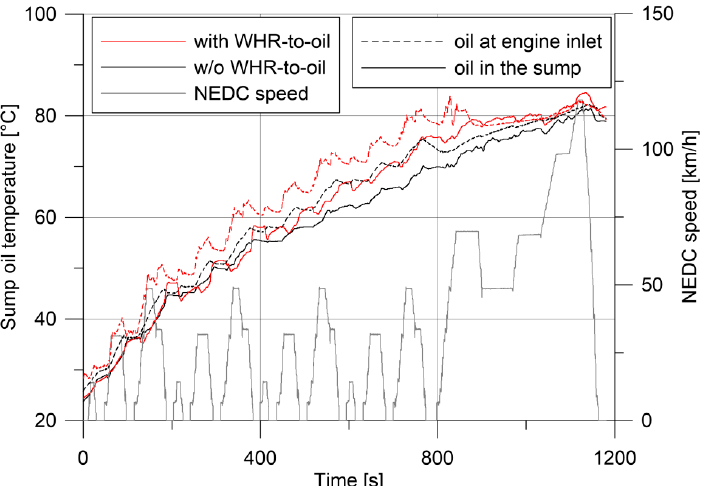
Figure 7. Oil temperature inside the sump and at the engine inlet in the two test cases performed: straight lines represent oil temperature in the sump, dashed lines the one of the oil at the engine inlet; red lines represent the temperature behavior with the WHR-to-oil, while the black ones represent without it. Energies 2018 , 11 , 10